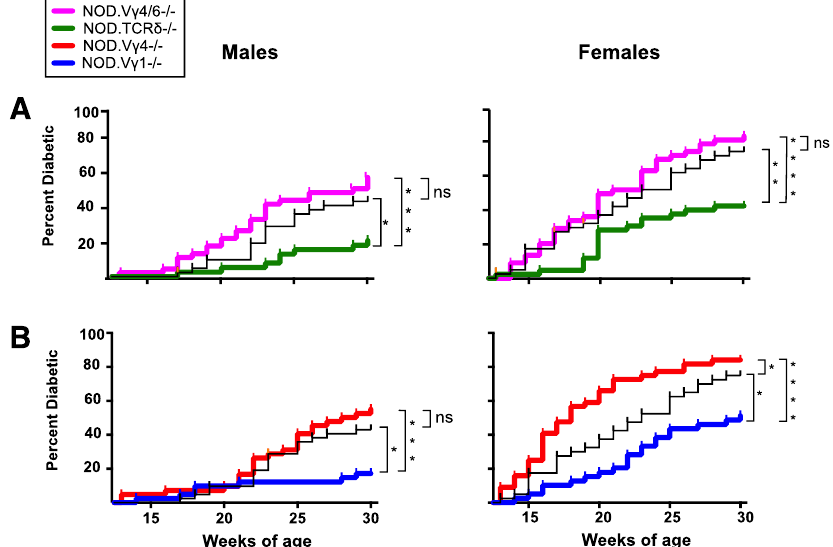
Figure 5. The incidence of spontaneous diabetes in γδ T cell subset-deficient NOD mice. Mice were monitored weekly for non-fasting blood glucose levels. Kaplan–Meier plots for each strain show the percent of the mice that had tested positive for diabetes by the indicated week of age, tested between 13–30 weeks of age, for males (left) and females (right). For each group, 38–46 mice were analyzed. ( A ). Results from male and female NOD.TCR δ -/- mice and NOD.V γ 4/6-/- mice juxtaposed to those from wt NOD controls during a similar time period. ( B ). Results from male and female NOD.V γ 4-/- and NOD.V γ 1-/- mice juxtaposed to those from the wt NOD controls during a similar time per i od .